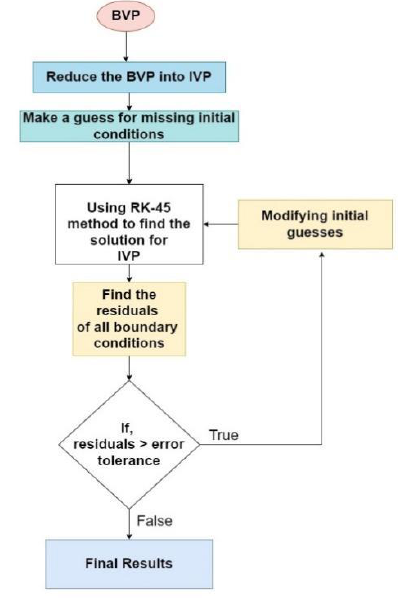
Figure 2. Numerical flow chart.